Question: What caption would you write for this figure?
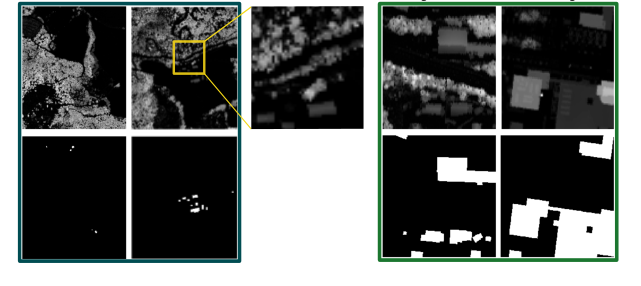
Answer: Scale differences as seen in our datasets. The top row shows LiDAR images at different scales from the train (left) and test (right) datasets. The corresponding building labels are shown in the bottom row. Even though our approach is pretrained for terrain-recovery on images as seen on the left, it translates easily to building with scales and sizes as seen on the right, indicating generalizability to objects at different scales (The magnification is to enable visual comparison between the two scales and aid reader comprehension and is not drawn to scale).